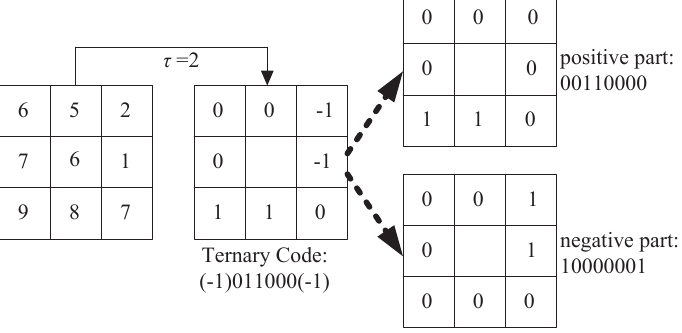
Figure 1. Calculation of the LTP with eight neighboring pixels.